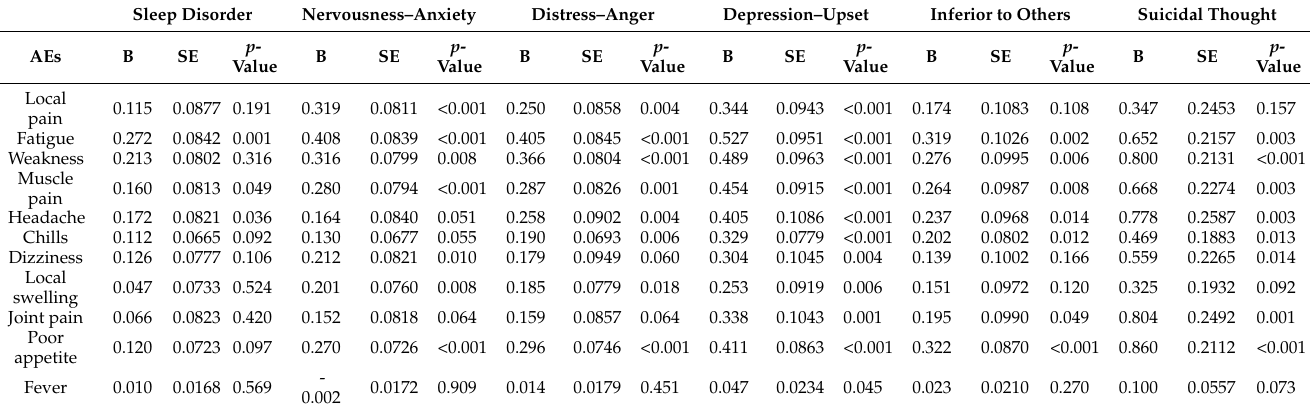
Table A1. Generalized estimating equations for psychological distress and adverse events.